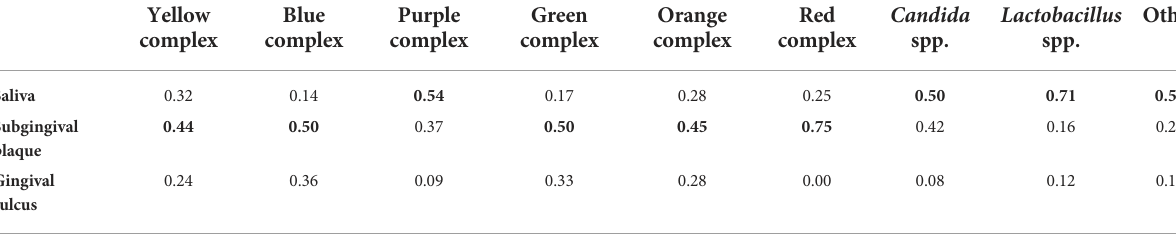
TABLE 4 Relative frequencies of the distribution of complexes and categories by samples in the groups of